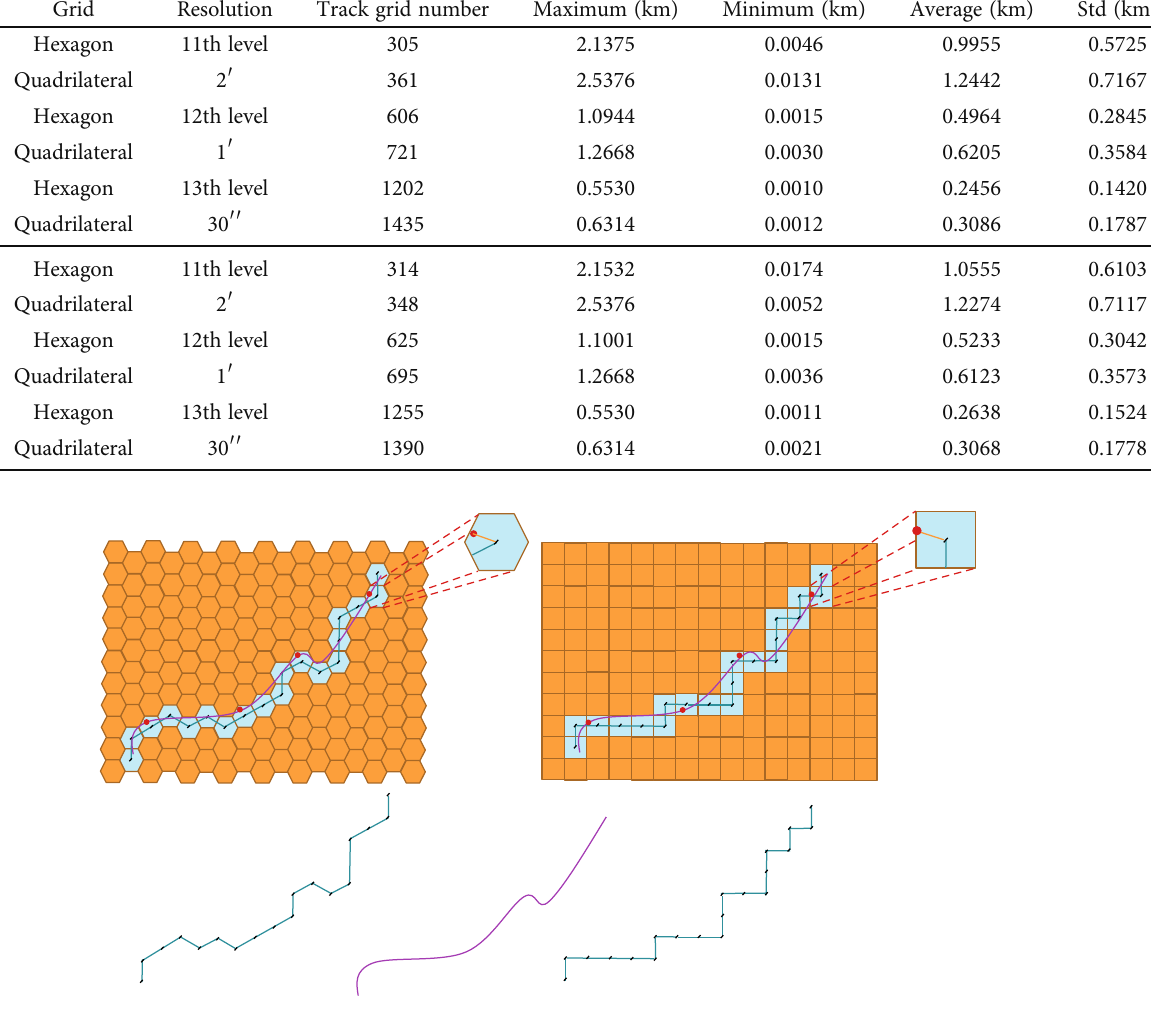
Figure 5: Schematic diagram of the grid matching positioning error. Table 6: Statistics of the grid matching positioning